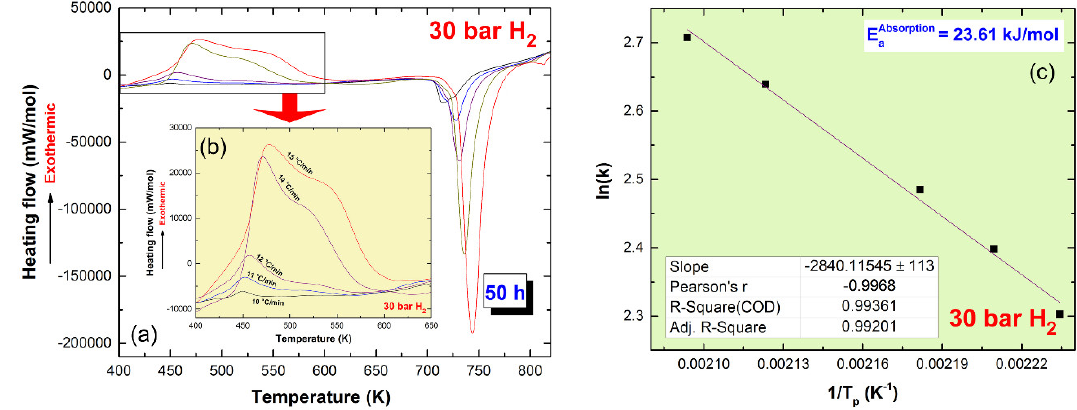
Figure 4. Hydrogenation/dehydrogenation behaviors and thermal stability of as-synthesized nanocomposite MgH 2 /5 wt% (2.5 ZrNi 5 + 2.5 Nb 2 O 5 ) powders. The high-pressure differential scanning calorimetry (HP-DSC) traces achieved under 30 bar hydrogen pressure for nanocomposite powders obtained after 50 h of milling time are shown in ( a ) at different heating rates. The hydrogenation peaks (low-temperature peaks) are presented in ( b ) with different temperature range. The hydrogenation peak temperature obtained at different heating rates were used to calculate the activation energy of hydrogenation, while using Arrhenius plot ( c ).